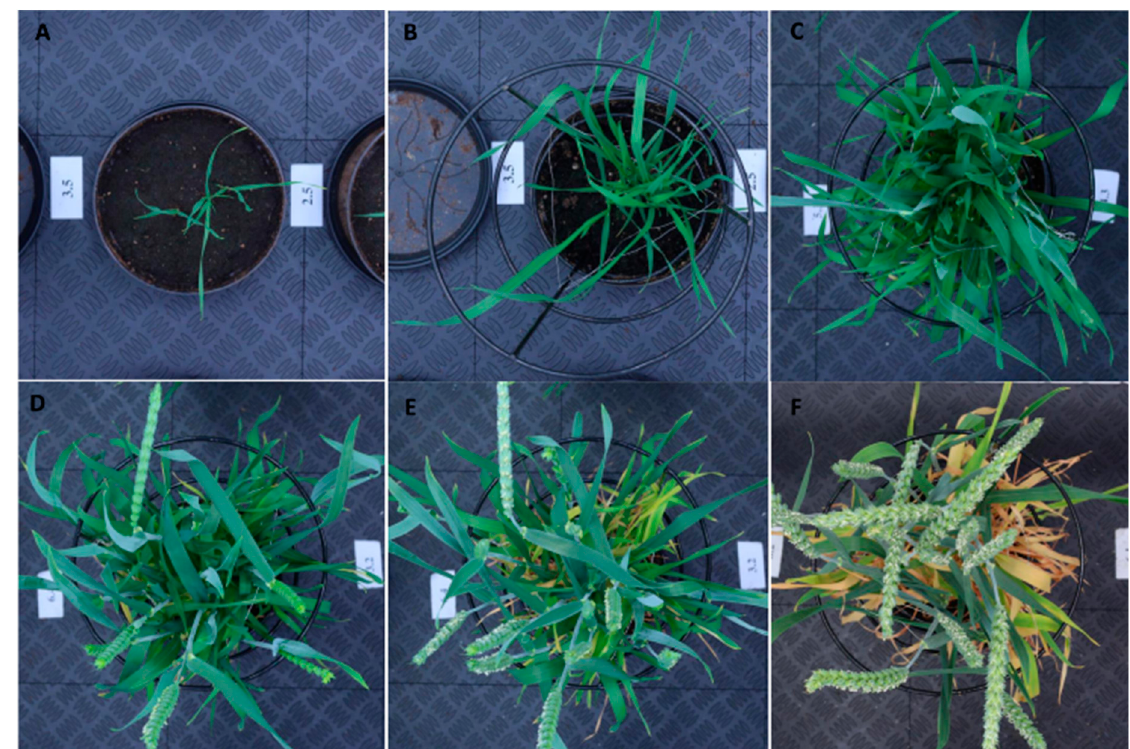
Figure 4. Representative red–green–blue (RGB) images from Phenocave before processing. Spring wheat plants at various growth stages: ( A ) seedling, ( B ) tillering, ( C ) stem elongation, ( D ) booting, ( E ) heading, and ( F ) grain filling.